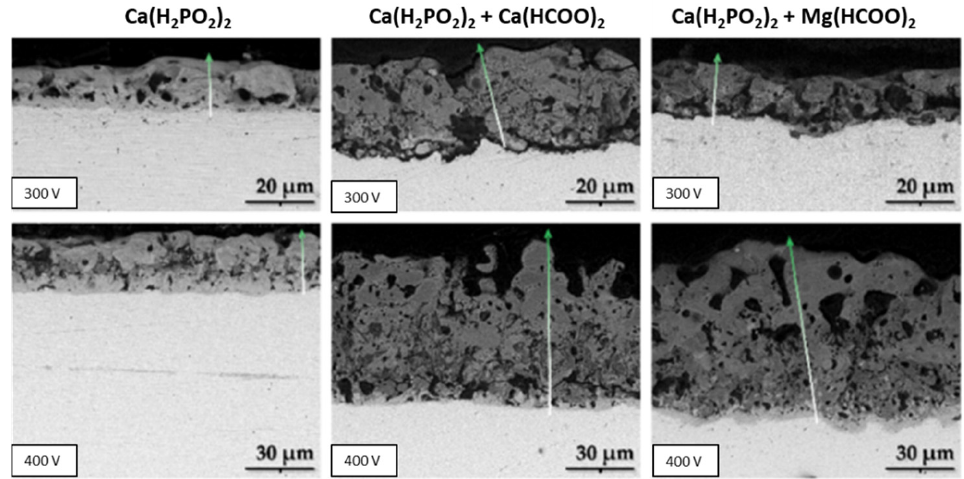
Figure 12. SEM cross-sectional images of the MAO-treated Ta surfaces obtained from different electrolyte compositions and at different limiting voltages. Adapted from Ref. [64].